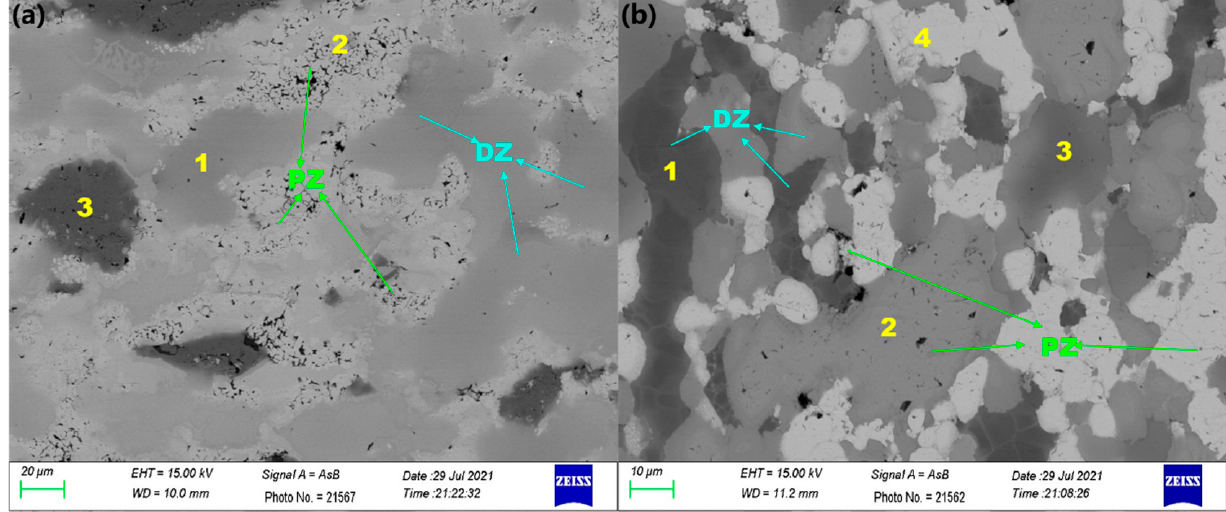
Figure 4. SEM images showing the microstructure morphology of alloys. Image ( a ) is presented for the TiZrNbMoV alloy, ( b ) presents the NbTiAlTaV alloy. DZ: Dense zone; PZ: Porous zone.